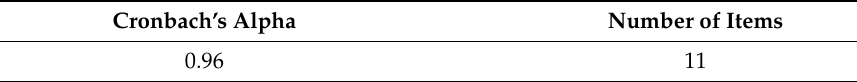
Table 2. Validity and reliability test.